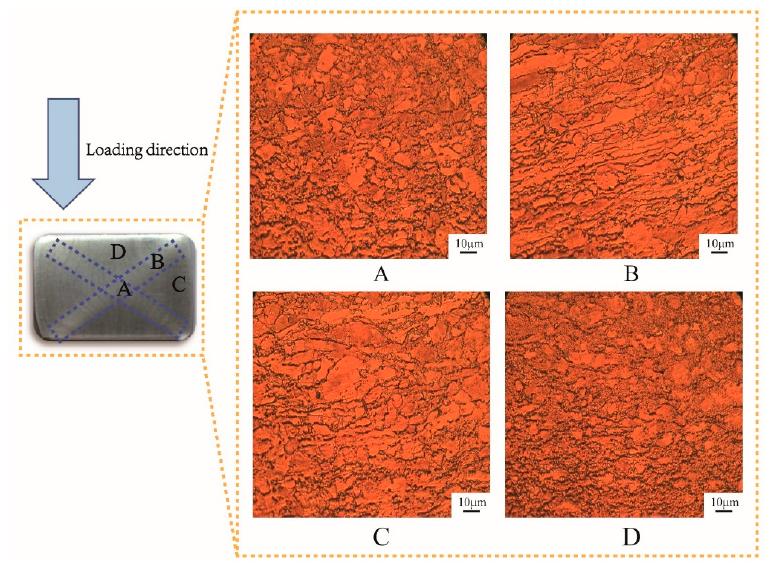
Figure 3. Microstructure of TC4 alloy in different zones after one cycle of MDIF: ( A ) central area; ( B ) shear region; ( C ) cross region Ⅰ ; ( D ) cross region Ⅱ .